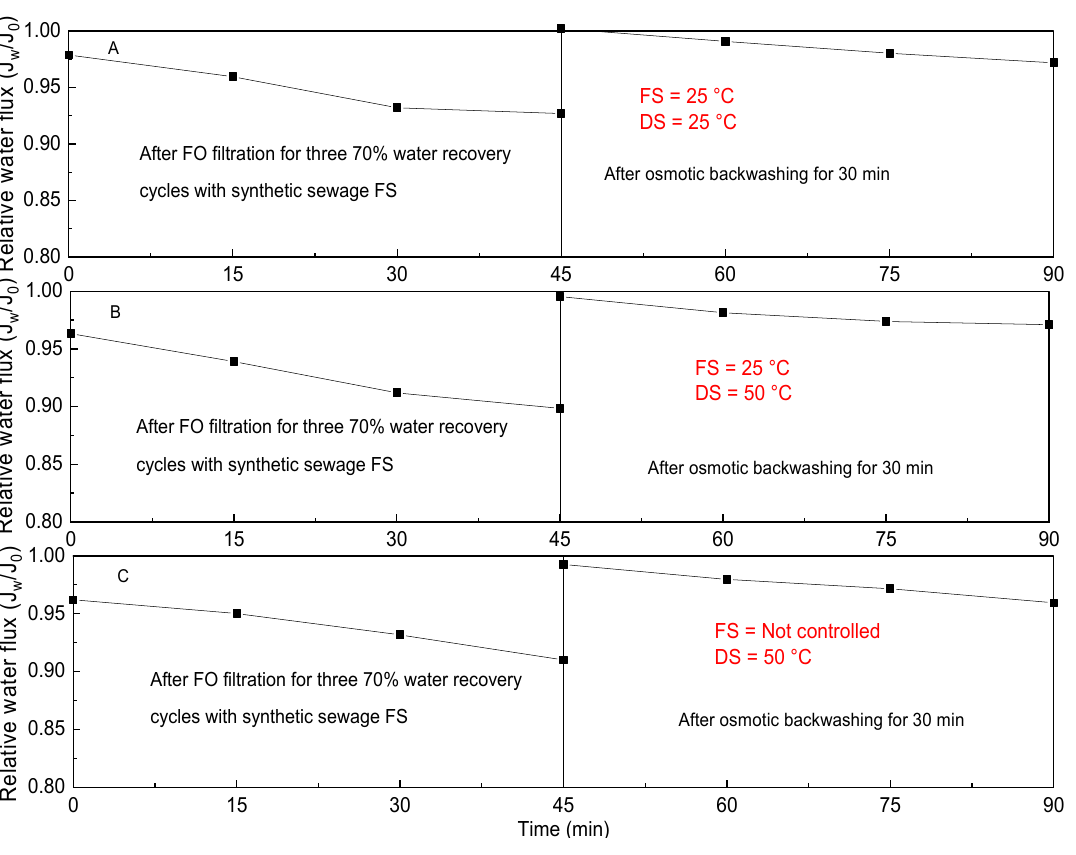
Figure 6. Comparing the water flux recoverability after fouling test of three consecutive cycles with a 70% water recovery rate treating synthetic municipal wastewater in the TFC FO process: ( A ) FS and DS = 25 °C, ( B ) FS = 25 °C and DS = 50 °C and ( C ) FS = not controlled (42 °C) and DS = 50 °C.